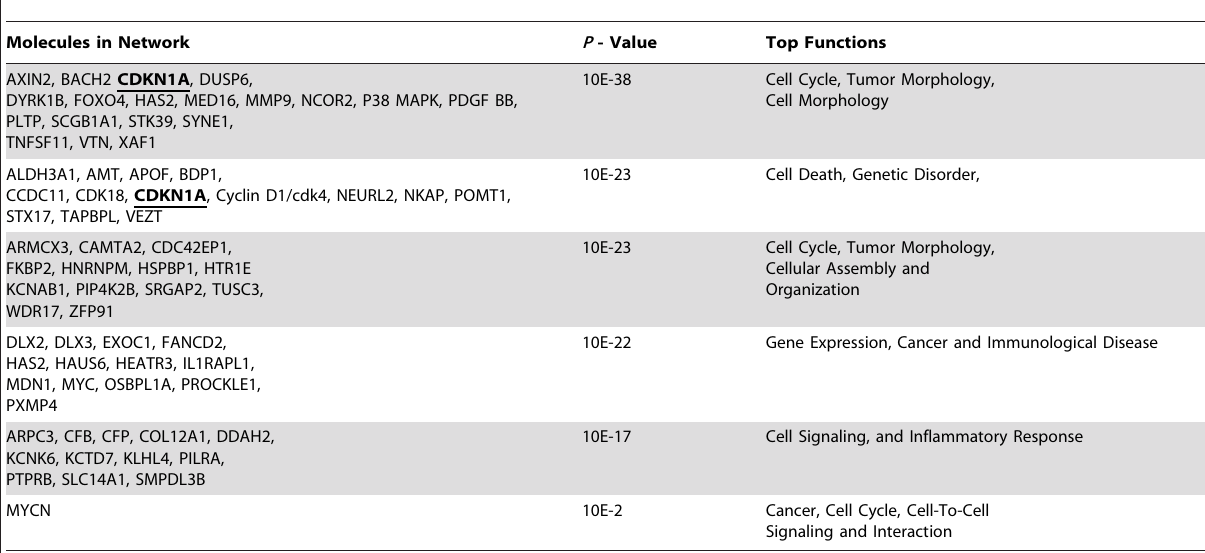
Table 1. Analysis of molecular pathways and functions of the differentially expressed mRNAs of combined treatment compared to control group in bladder tumor xenografts.